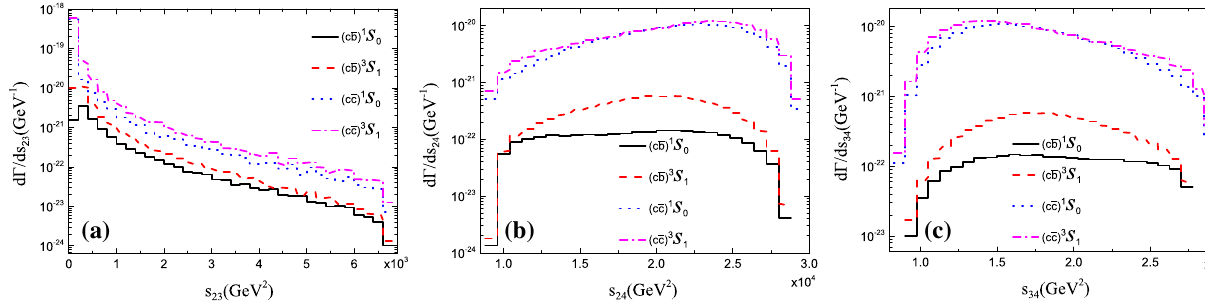
Fig. 2 The differential decay widths d (cid:2)/ ds 23 ( a ), d (cid:2)/ ds 24 ( b ), and d (cid:2)/ ds 34 ( c ) for t → | ( c ¯ Q ) [ n ](cid:5) + Q + Z 0